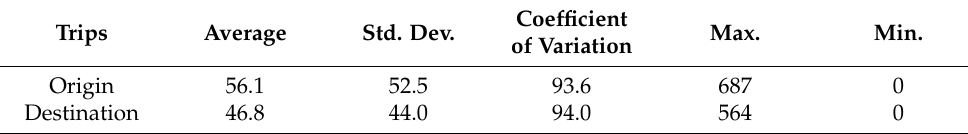
Table 1. Descriptive statistics of the density of origins and destinations per hectare. Trips Average Std. Dev.